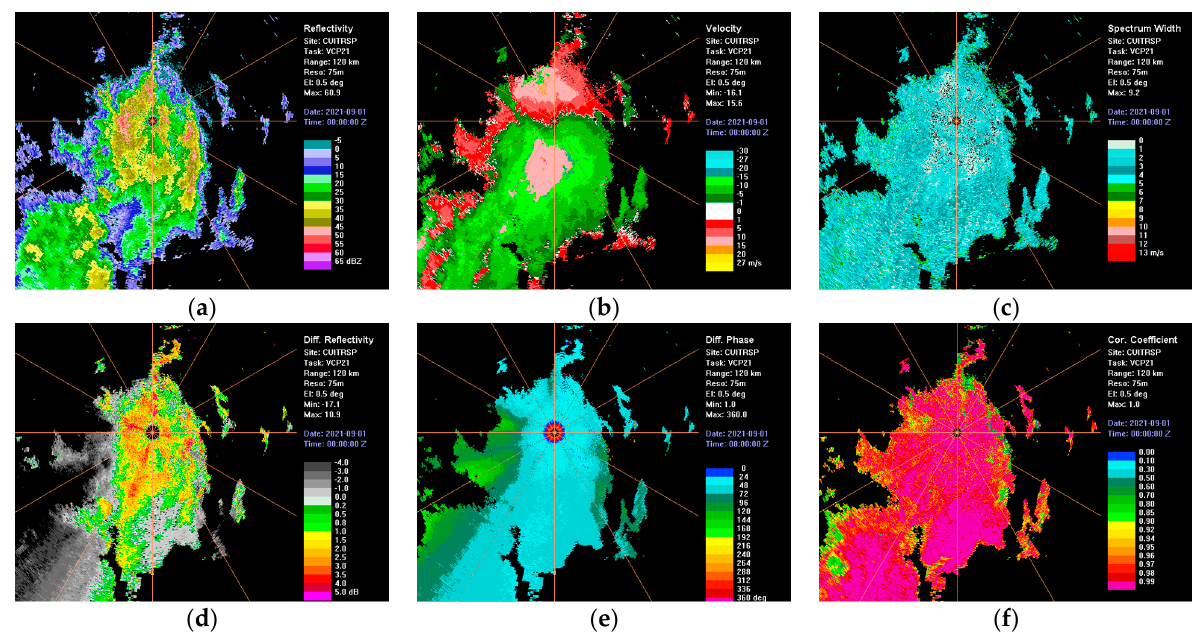
Figure 6. The PPI display of simulation radar base data. ( a ) Reflectivity; ( b ) radial velocity; ( c ) spec- trum width; ( d ) differential reflectivity; ( e ) differential phase; ( f ) correlation coefficient.